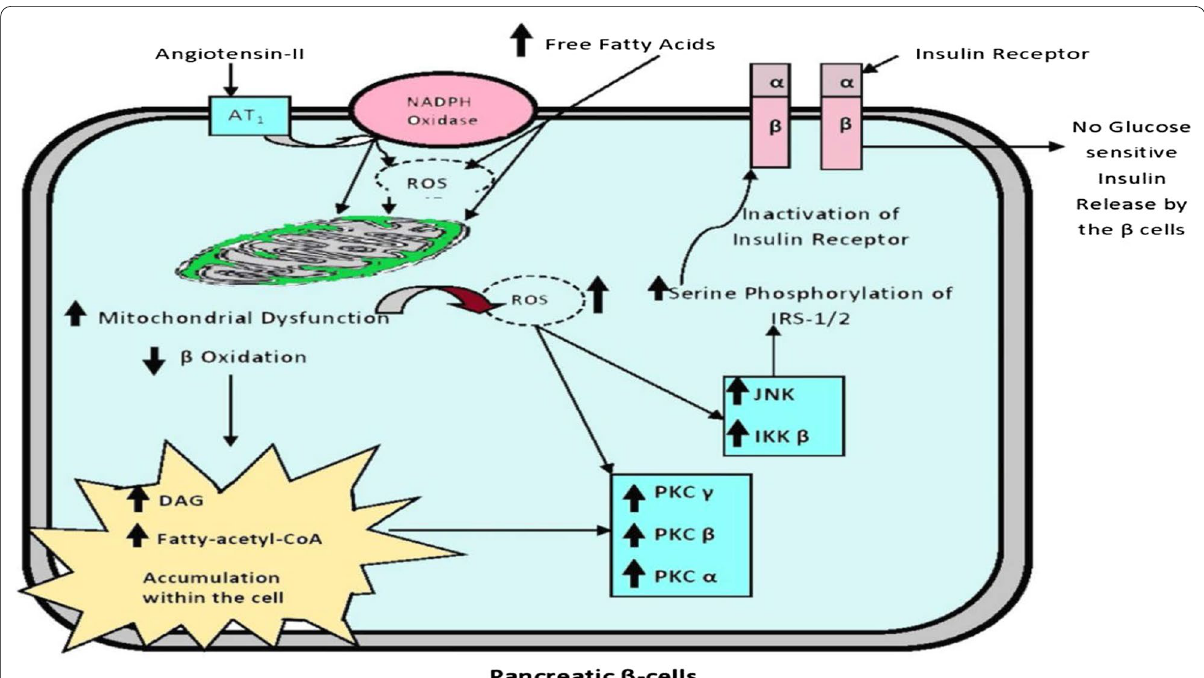
Fig. 3 Mitochondrial dysfunction disrupts insulin secretion from pancreatic β-cells. AT 1: Angiotensin II receptor type 1; ROS: Reactive oxygen species; JNK:c-Jun N-terminal kinase; IKK-β: Inhibition of nuclear factor kB kinase; PKC: Protein kinase C; DAG: Diacylglycerol; IRS: Insulin receptor substrate